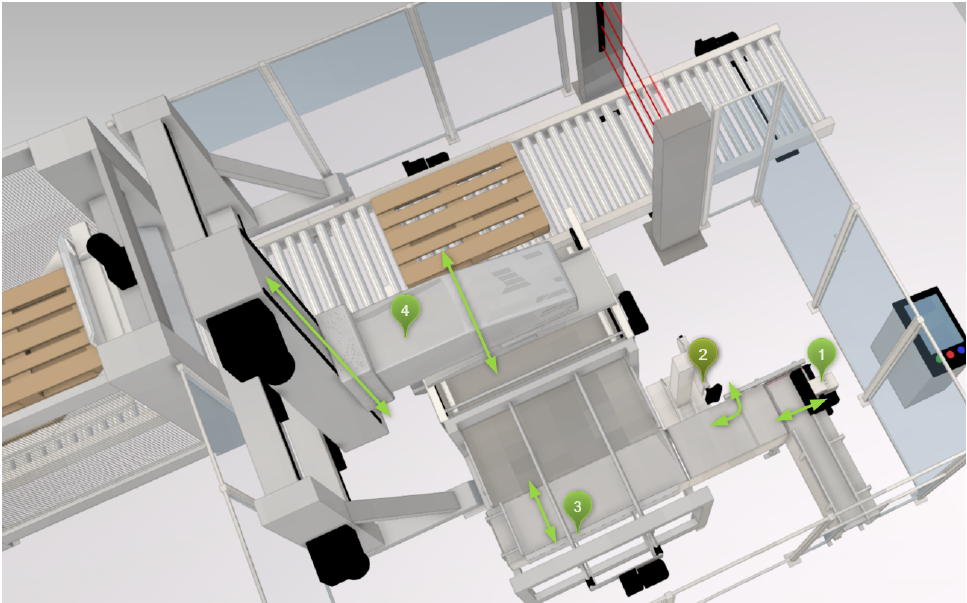
Figure 9. Simulation model used for evaluation: end-of-line palletizing portal packaging system. Motion controlled by PLC applications are marked in green. Physical control units: Nr. 1 pusher, Nr. 2 rotary vane, and Nr. 3 carriage. Virtualized control unit: Nr. 4 gripper